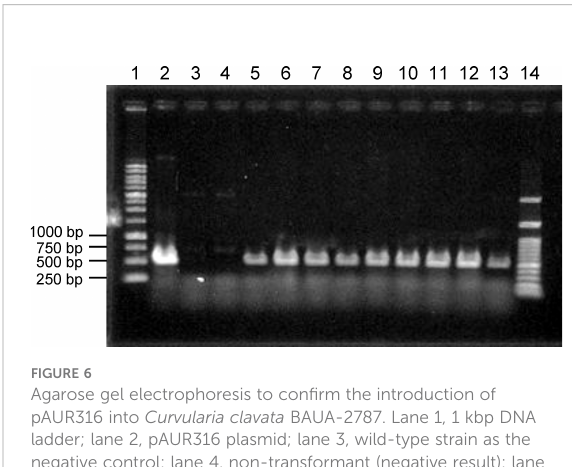
FIGURE 6 Agarose gel electrophoresis to con fi rm the introduction of pAUR316 into Curvularia clavata BAUA-2787. Lane 1, 1 kbp DNA ladder; lane 2, pAUR316 plasmid; lane 3, wild-type strain as the negative control; lane 4, non-transformant (negative result); lane 5-13, pAUR316 transformants; and lane 14, 100 bp DNA